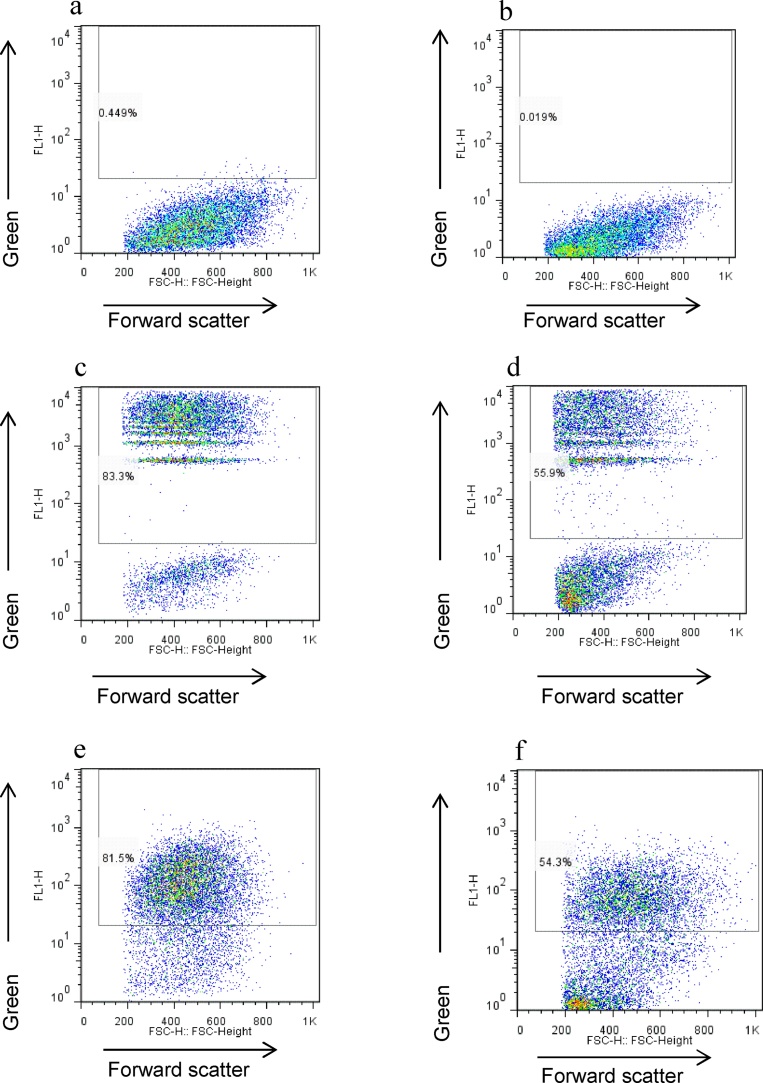
Culture in DC medium reduces macrophage phagocytosis of apoptotic cells and beads. Day 7 bone marrow-derived Mφ were incubated for 5 days in macrophage (Mφ) or dendritic cell (DC) medium (n = 3 mice). Cells were then incubated with CellTracker Green labeled apoptotic murine thymocytes or 3 μm Fluoresbrite YG microsphere beads for 60 min. Cells were vigorously washed and detached from the plates for flow cytometric assessment of the proportion of cells that had phagocytosed apoptotic cells or beads. Representative flow cytometry dot plots of Mφ cultured in Mφ medium (cells alone (a), following incubation with beads (c) or apoptotic cells (e)) or DC medium (cells alone (b), following incubation with beads (d) or apoptotic cells (f). Quantification of the proportion of cells exhibiting phagocytosis demonstrates that Mφ cultured in Mφ medium (Mφ/Mφ) remain highly phagocytic but exhibit reduced phagocytic capacity following incubation in DC medium (Mφ/DC) (g & h). ** p < 0.01, ***p < 0.001 (For interpretation of the references to colour in this figure legend, the reader is referred to the web version of this article).